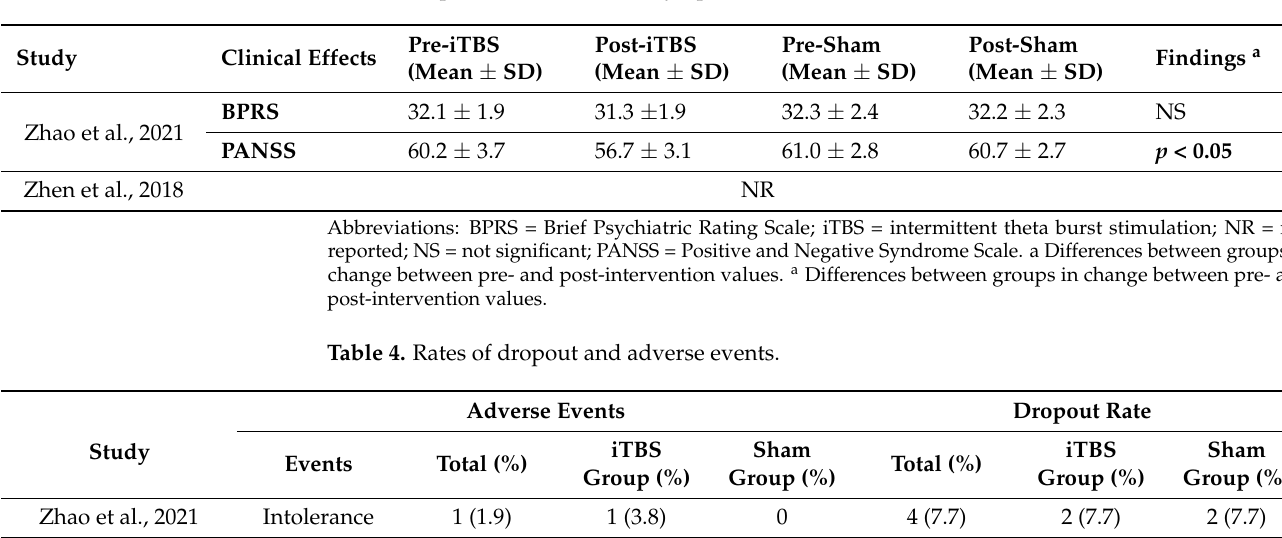
Table 3. Improvement in clinical symptoms after iTBS.